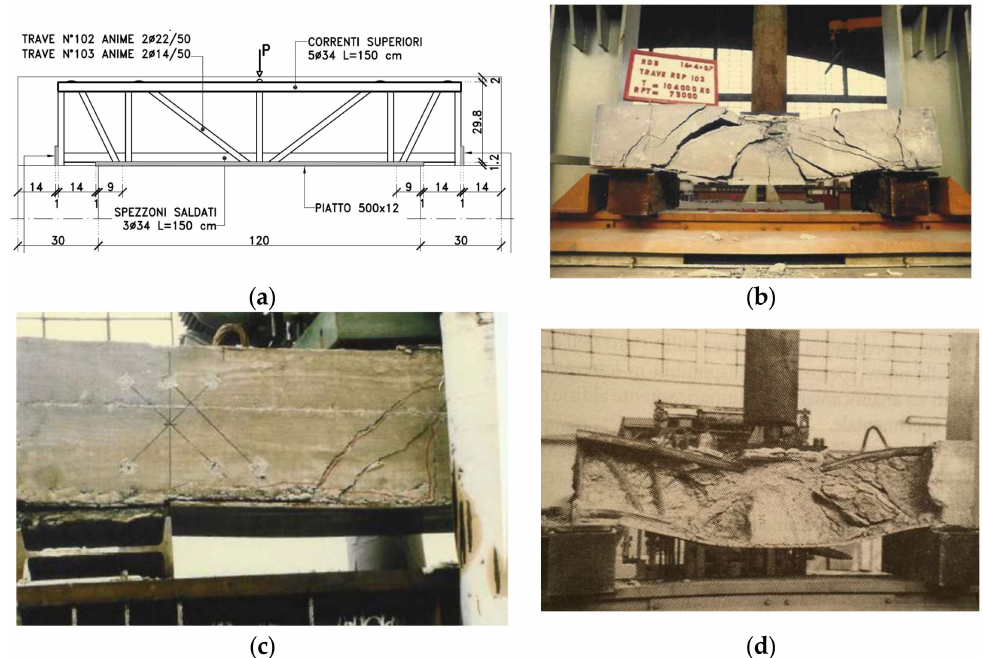
Figure 14. ( a ) Specimen for shear test; ( b ) shear failure; ( c ). Crack pattern of Hybrid Steel Trussed Concrete Beam (HSTCB) with separation of the lower steel plate; ( d ) specimen at the end of the test with no spalling of the concrete thanks to the presence of the lower steel plate.